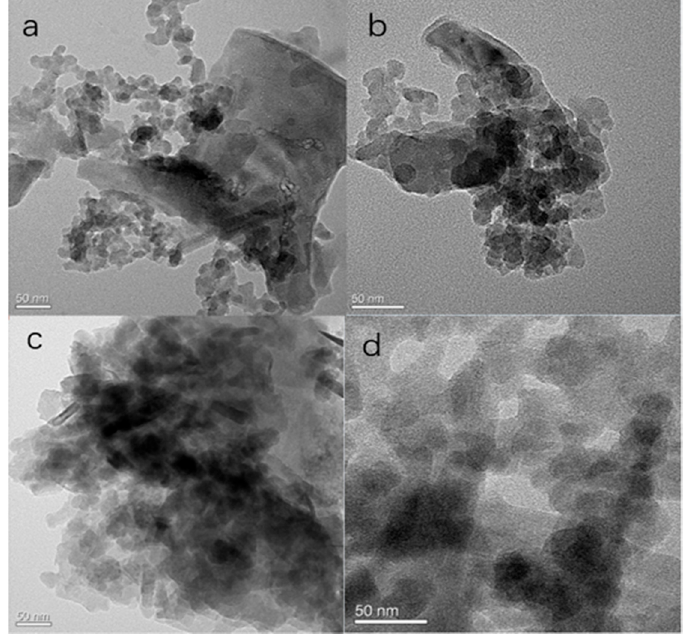
Figure 2. TEM patterns of ( a ) SC, ( b ) A-SC, ( c ) Glu–A-SC, and ( d ) Lip–Glu–A-SC. Scale bar represents 50